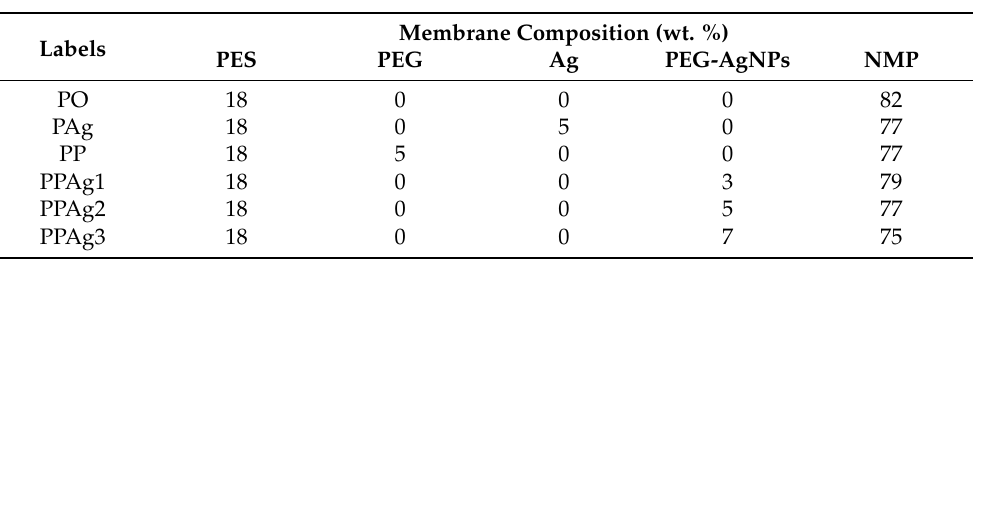
Table 1. The composition of the prepared membrane